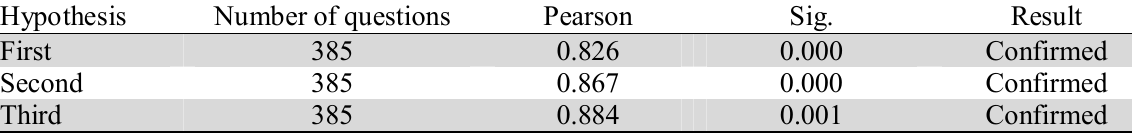
The results of Pearson correlation test